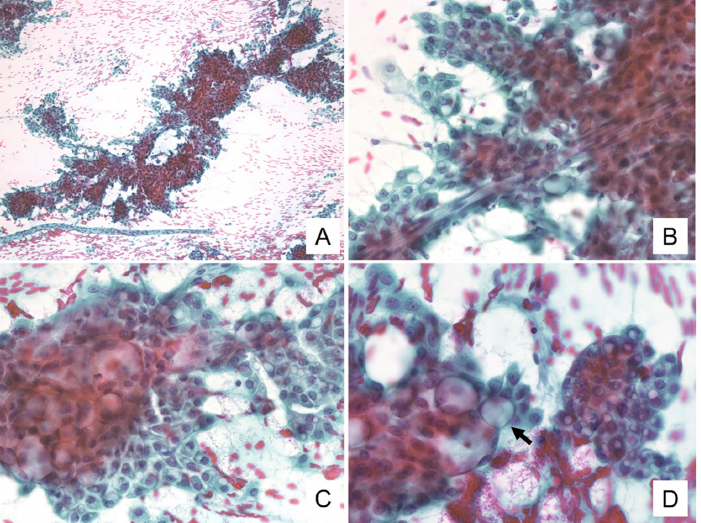
Figure 1. Cytologic findings of Papanicolaou staining. ( A ) Large clusters with papillary to dendritic pattern and hemorrhagic background are visible. ( B ) Blood vessels penetrate into the cell cluster. The neoplastic cells have vacuolated cytoplasm and enlarged nuclei, with fine chromatin and small, distinct single nucleoli. ( C ) The cell borders are distinct. The hyaline globule-like structures are seen. ( D ) Neoplastic cells have numerous cytoplasmic vacuoles, and some of them contain secretions or show intracytoplasmic lumina (allow) (( A – D ): Case 1. ( A ): ×100, ( B , C ): ×400, ( D ): ×600).